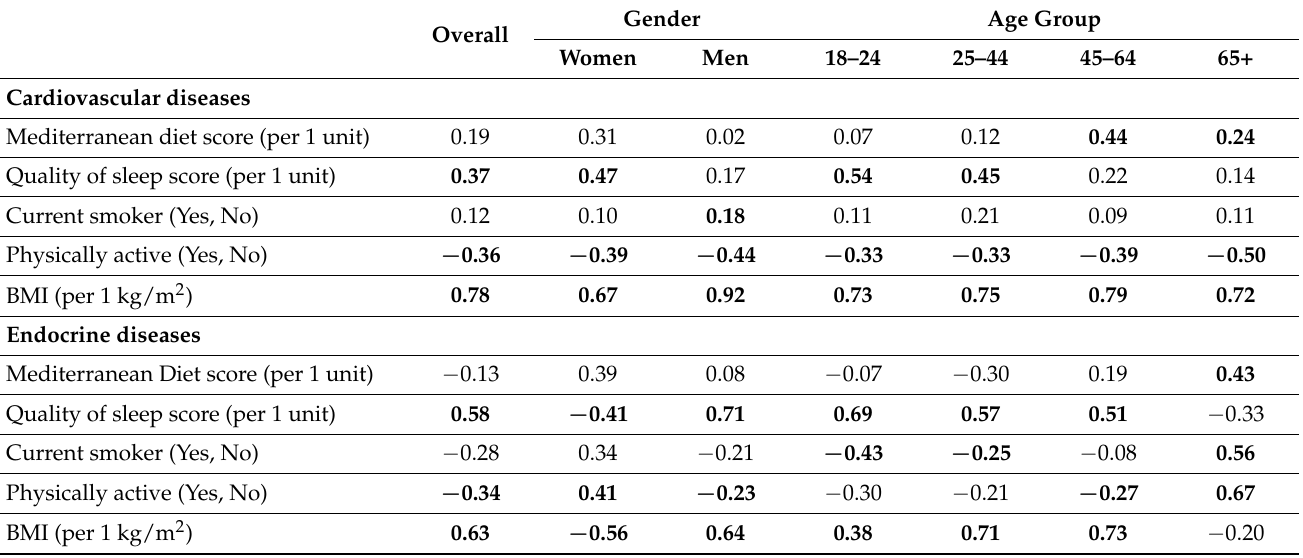
Table 3. Hierarchical discriminant analysis (standardized Fisher’s classification function coefficients,